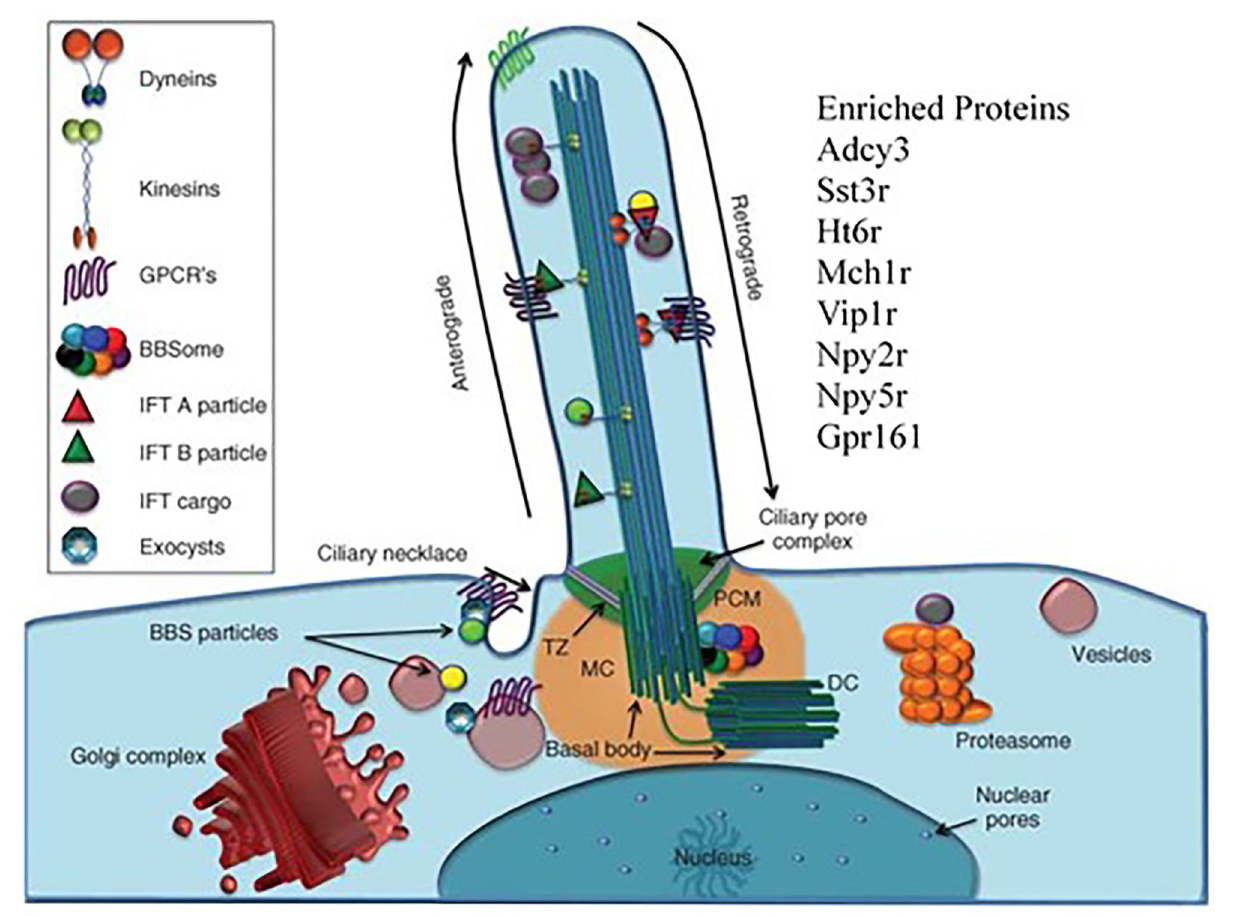
FIGURE 5 | The primary cilia as target for the effects of chronic ethanol consumption. There are to our knowledge, no reports linking the brain’s primary cilia to ethanol preference, chronic ethanol exposure or excessive ethanol consumption. Our data shows that there is a strong cilia signal associated with individual variation in preference within the context of chronic ethanol exposure. The primary cilium is a long, thin organelle protruding from the apical surface of almost all cell types. This structure is formed when the cell is in G0 or G1 phase, and often during S/G2 phase (104). The timing of cilium formation, “ciliogenesis,” is restricted to these stages of the cell cycle because the cilium is rooted at its base by the basal body, which is derived from the mother centriole of the centrosome (105). Differently than mobile cilia, the axoneme of the primary cilium has a “9 + 0” structure and is not mobile. The “primary cilia” are fundamentally important for normal cell signaling during development and homeostasis, resulting in the adoption of the term “cell’s antenna” (106). These signaling functions are carried out by the myriad of signaling molecules.